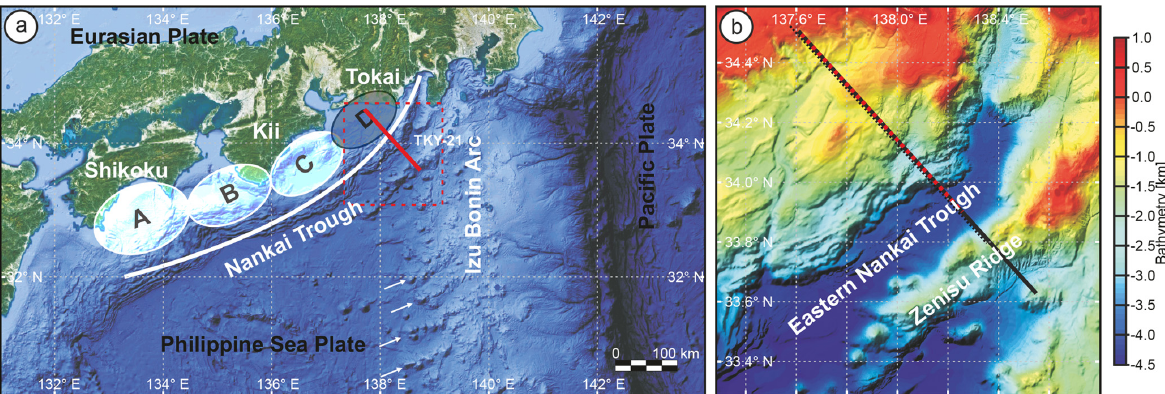
Figure 1. (a) Partitioning of the Nankai Trough into four segments as described by Ando (1975). Region D was left unruptured during the most recent sequence of two large earthquakes (1944 Tonankai and 1946 Nankaido). The solid red line represents the seismic profile of the SFJ OBS experiment. White arrows mark the cyclic volcanic ridges developing on the flank of the Izu–Bonin Arc. (b) Zoomed view of the survey area, overlaid with the bathymetry variations. The solid grey line and the dashed red line represent the OBS shot and receiver profile, respectively, while the dashed black line corresponds to the MCS profile (Górszczyk et al., 2017).